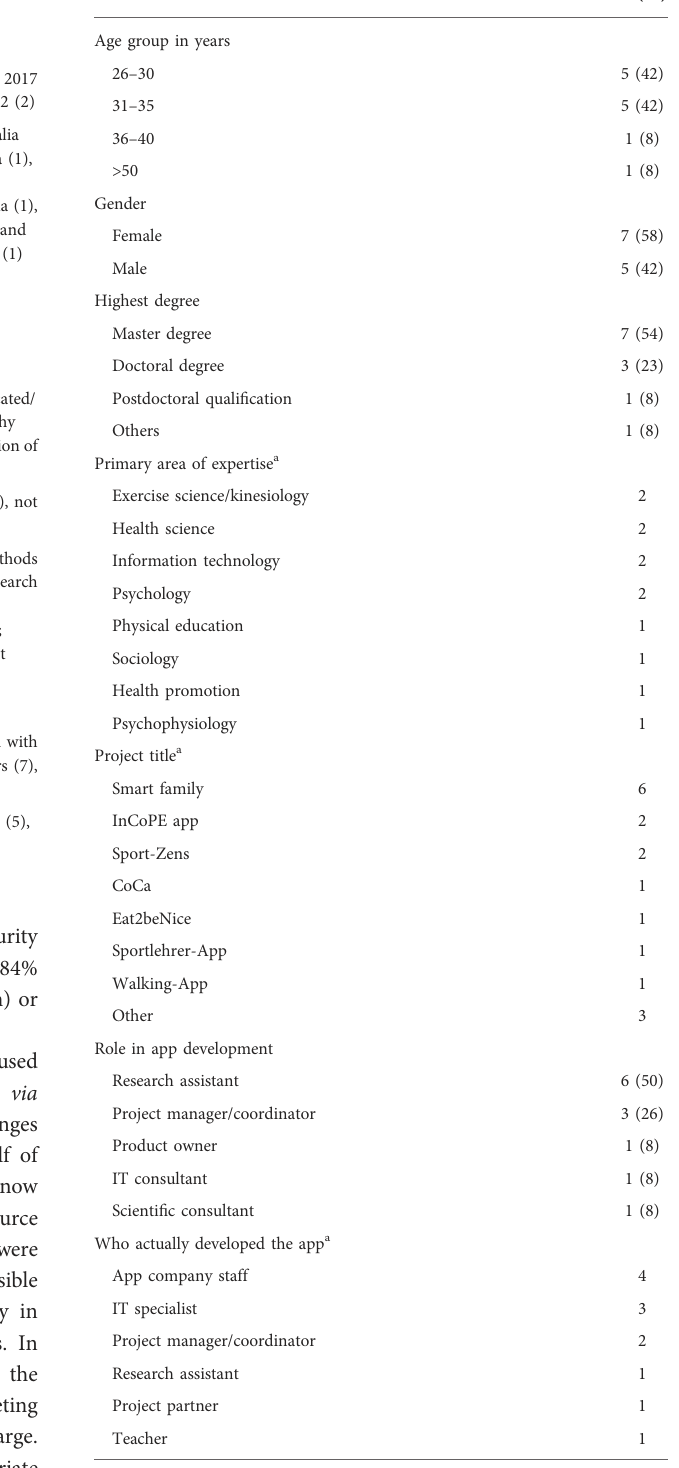
TABLE 2 Characteristics and primary area of expertise and app project information of the respondents ( N =12).